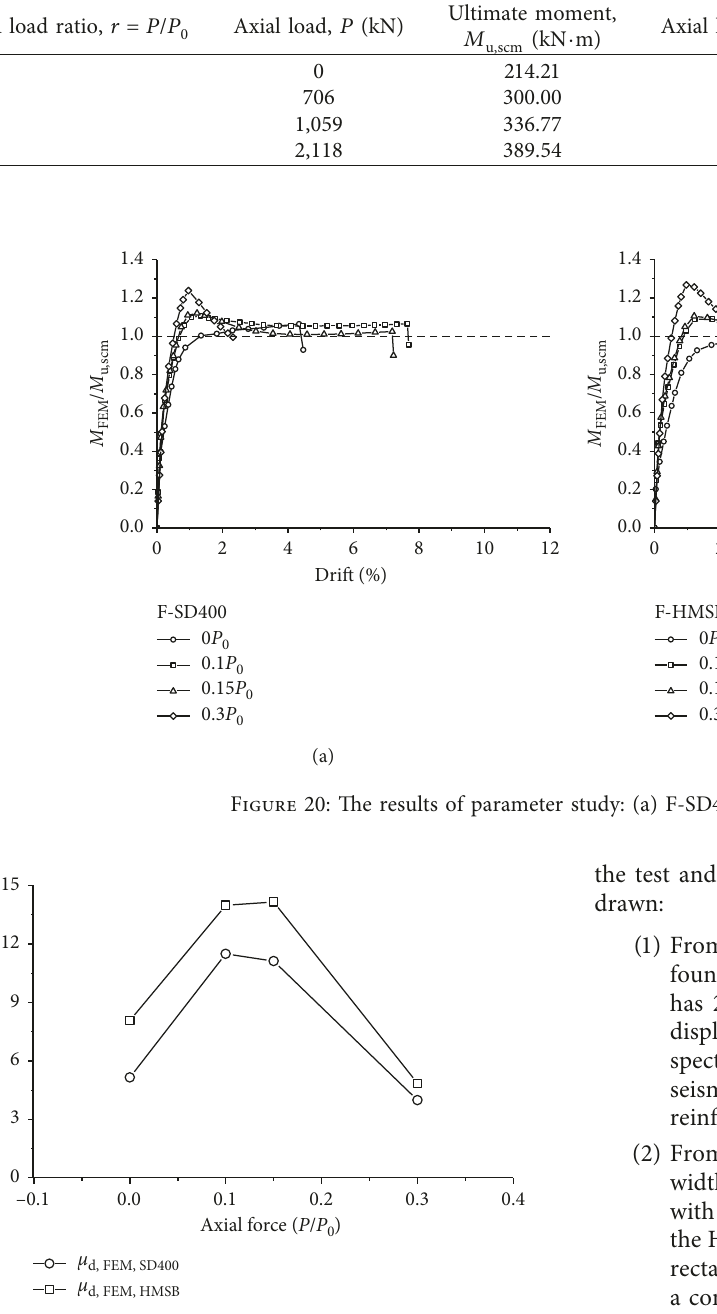
Figure 21: Displacement ductility of FEM analysis